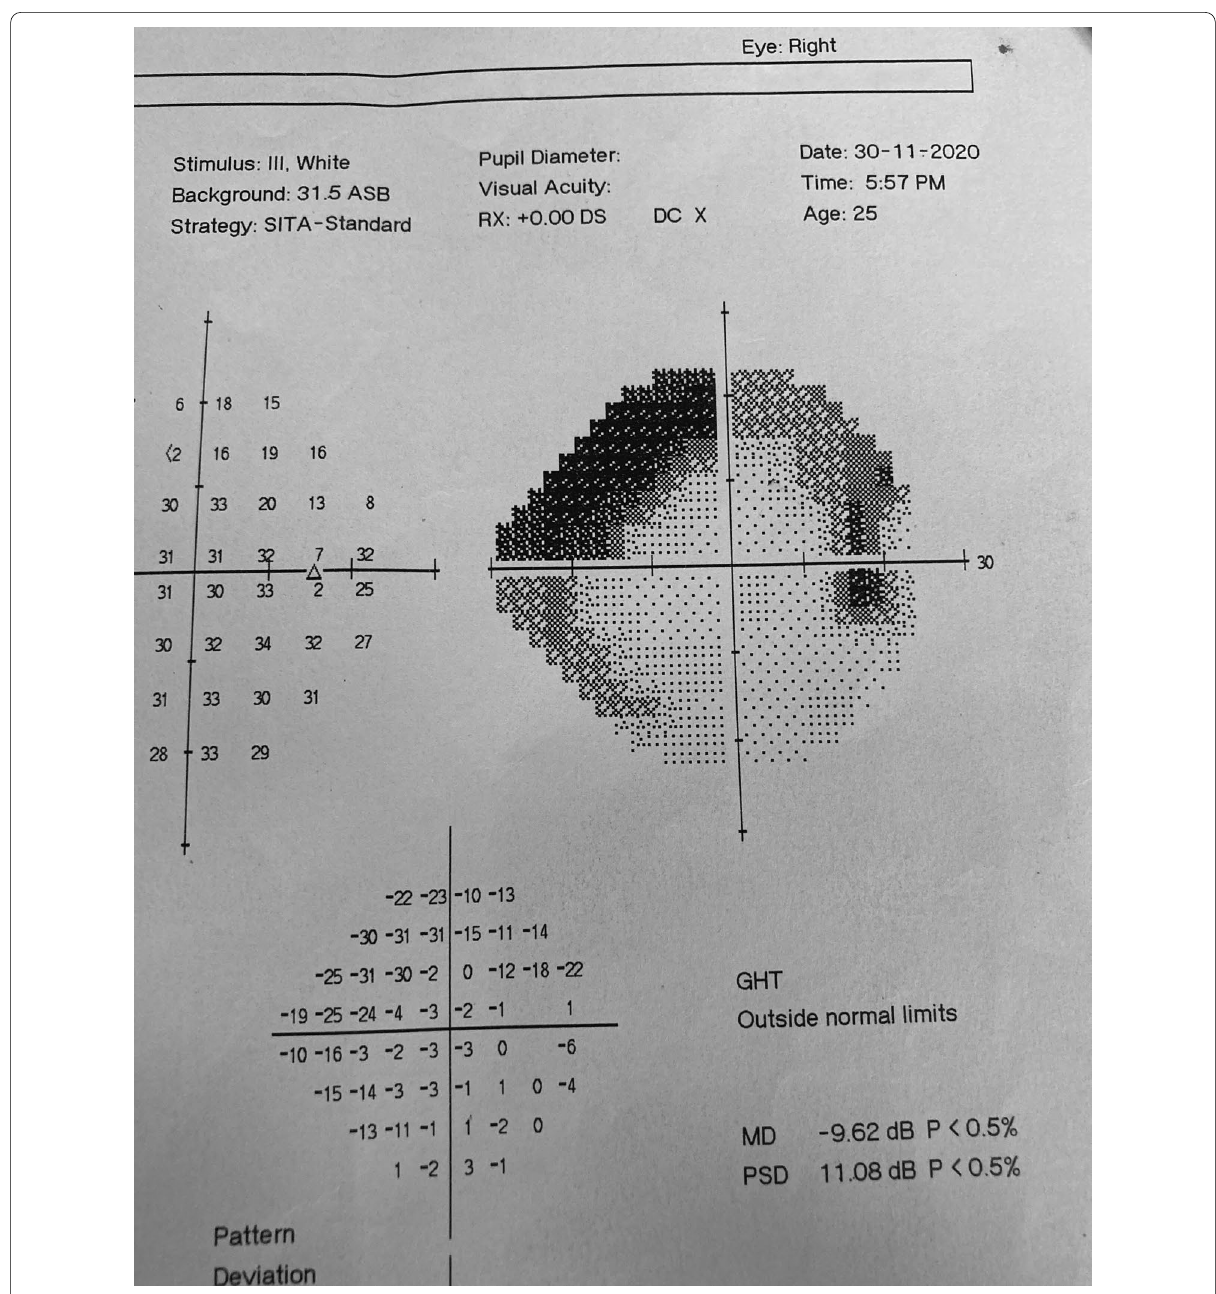
Fig. 7 Perimetry of right eye showing superior temporal arcuate